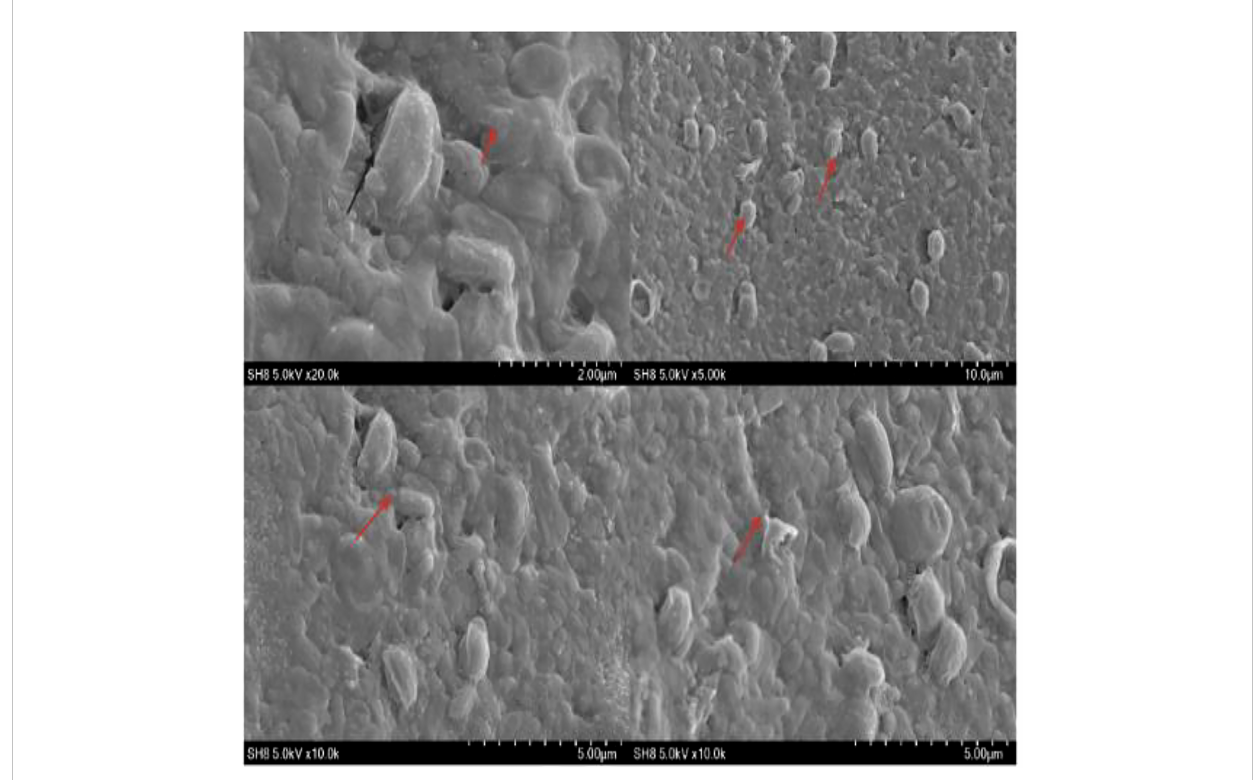
FIGURE 6 Scanning electron microscopy at a different resolution. The arrows indicate the presence of the bio fi lm and surface characteristics of bacterial isolate SH-8.